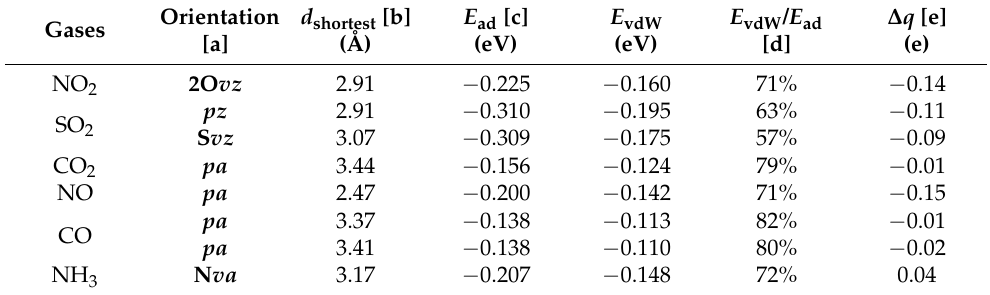
Table 1. Parameters for the most stable adsorption configurations of gas molecules on perfect SLBP. ∆ q [e] d shortest [b] E ad [c] E vdW E vdW / E ad Orientation Gases [a] (Å) (eV) (eV) [d] (e) NO 2 2O vz 2.91 − 0.225 − 0.160 71% − 0.14 pz 2.91 − 0.310 − 0.195 63% − 0.11 SO 2 S vz 3.07 − 0.309 − 0.175 57% − 0.09 CO 2 pa 3.44 − 0.156 − 0.124 79% − 0.01 NO pa 2.47 − 0.200 − 0.142 71% − 0.15 pa 3.37 − 0.138 − 0.113 82% − 0.01 CO pa